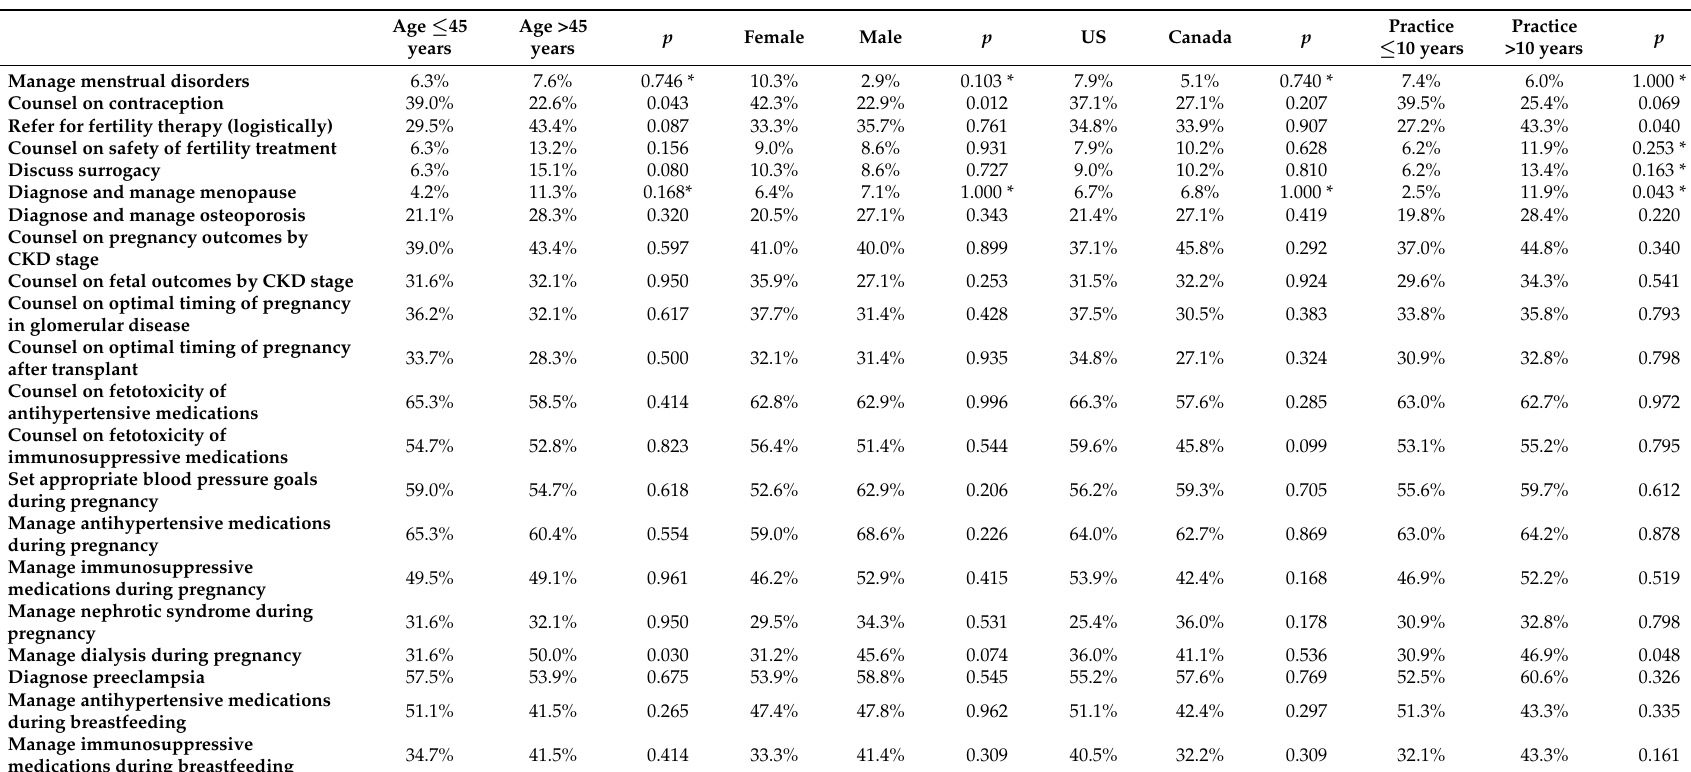
Table 2. Percentage of nephrologists who were confident or very confident in counseling or managing women's health issues, by demographic